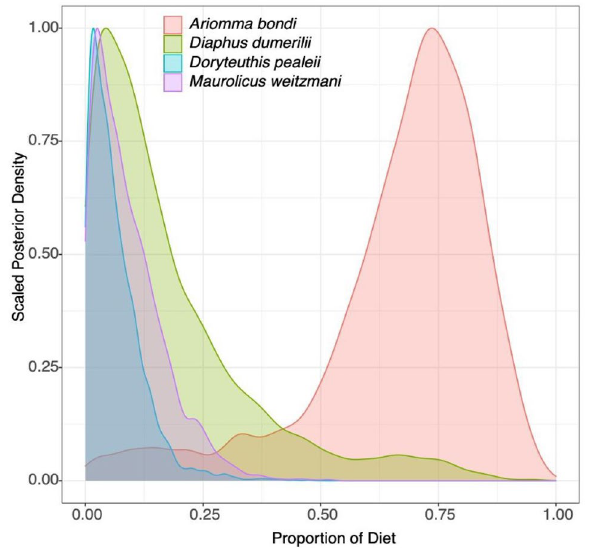
Figure 4. Proportion of dietary contribution of four different potential prey items to Rice’s whale ( Balaenoptera ricei ) diets using Bayesian mixing model analysis with trophic enrichment factors (Borrell et al. 48 ) of stable isotope samples taken in the Gulf of Mexico.